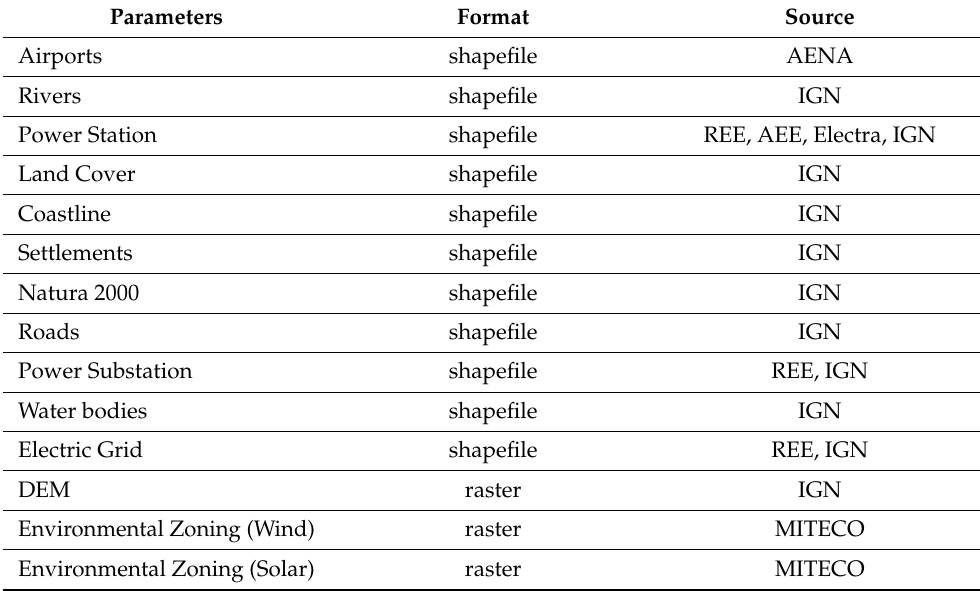
Table 5. Sources and Geographic Information System (GIS) layers for the Spanish case.